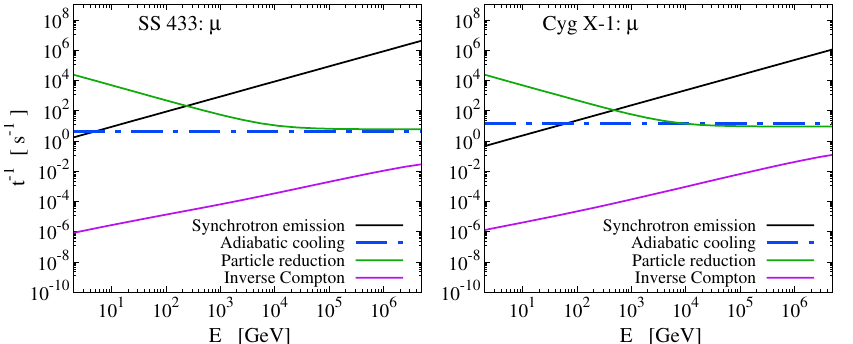
Figure 2. Cooling rates for muons ( µ ± ) produced in the jets of the systems SS 433 and Cygnus X-1. Similarly to the electron case and because of their size, muons also lose energy due to Inverse Compton scattering.